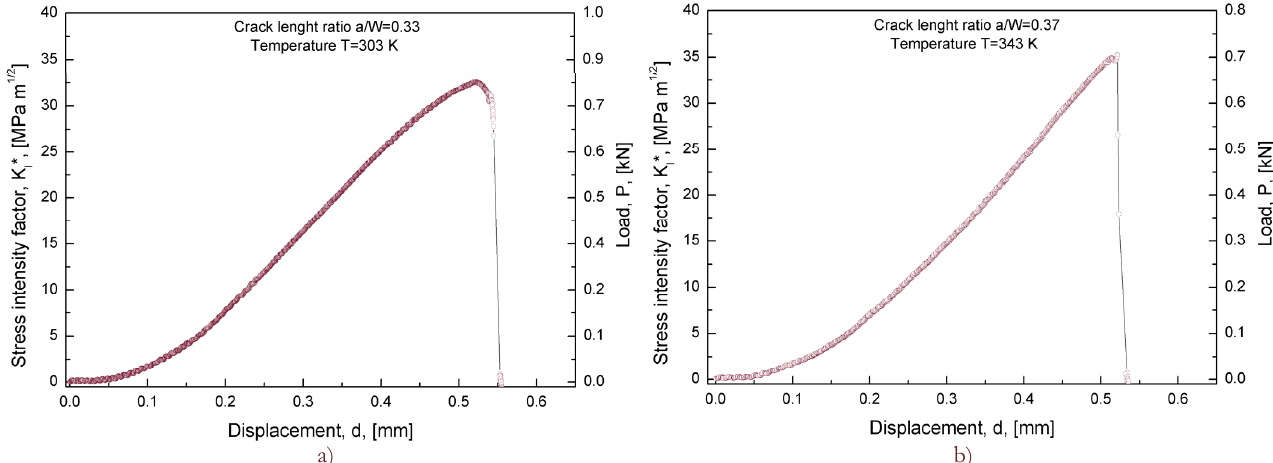
Figure 12: Isothermal mechanical tests of SEC specimens in terms of applied load ( P ) and mode I stress intensity factor ( K function of the crosshead displacement ( d ): a) T =303 K and b) T =343 K